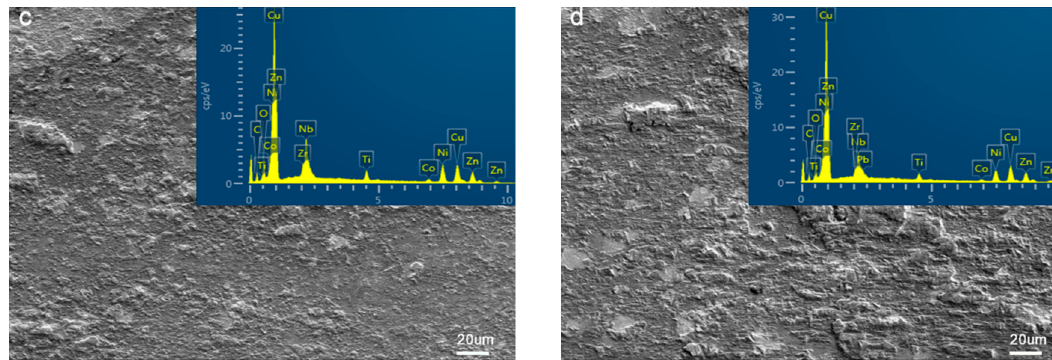
Figure 5. The SEM images of the Ni-based BMG pins under different loads with a sliding speed of 5 mm/s and a sliding time of 100 min: ( a – d ) the surfaces of the Ni-based pins under different loads of 1 kg, 3 kg, 5 kg, 10 kg, respectively. The corresponding insets show the EDS mapping results of the transfer layers on the pins.